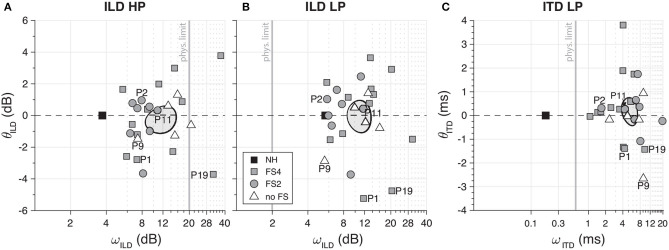
Overall bias (θ) and sensitivity (ω) of interaural level difference (ILD) high-pass (A) and low-pass (B) and interaural timing difference (ITD) low-pass (C). Vertical gray lines represent the cue's physiological range values. In all panels, the mean and variability (95% confidence interval) of the data of BICI users are represented by ellipses. As reference, the mean of the NH results is marked with a gray square. Note that for ILD and ITD low-pass, all CI users fell outside the boundaries (2 dB and 600 μs, respectively) indicated by the physiological range. Normal-hearing (NH) controls, however, demonstrated clear ITD LP perception.